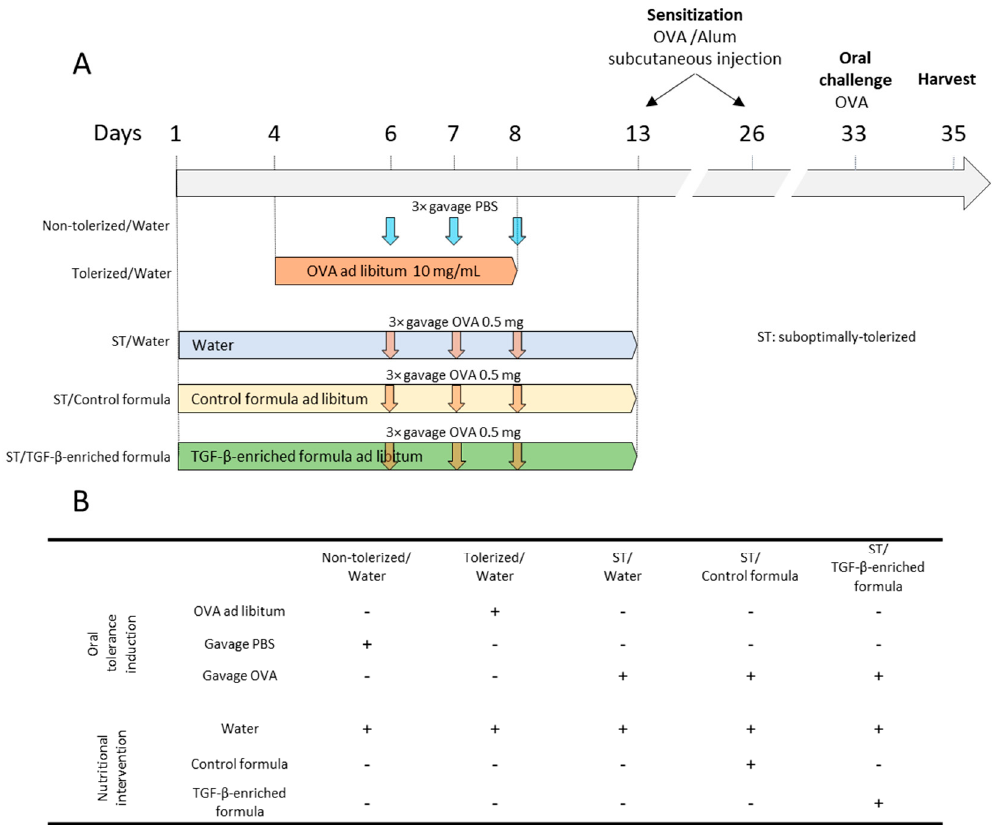
Figure 1. ( A ) Mouse model to assess the impact of a TGF- β -enriched formula on oral tolerance to a newly introduced allergen. A food allergy was induced in 5-week-old female mice using two subcutaneous injections at days 13 and 26 with OVA (100 µ g) in alum (1 mg), followed by one oral challenge with OVA (50 mg) via intragastric administration. Oral tolerance was induced with OVA (10 mg / mL) administered ad libitum from day 4 to day 8. Mice receiving a suboptimal-tolerogenic dose of OVA (0.5 mg) using a gavage on days 6, 7, and 8 had free access to either water, non-enriched formula (control formula), or TGF- β -enriched formula from day 1 to day 13. Non-tolerized / water mice only received PBS using a gavage on days 6, 7, and 8. ( B ) represents the di ff erent groups receiving ( + ) or not-receiving (-) OVA for tolerance induction and a nutritional intervention.